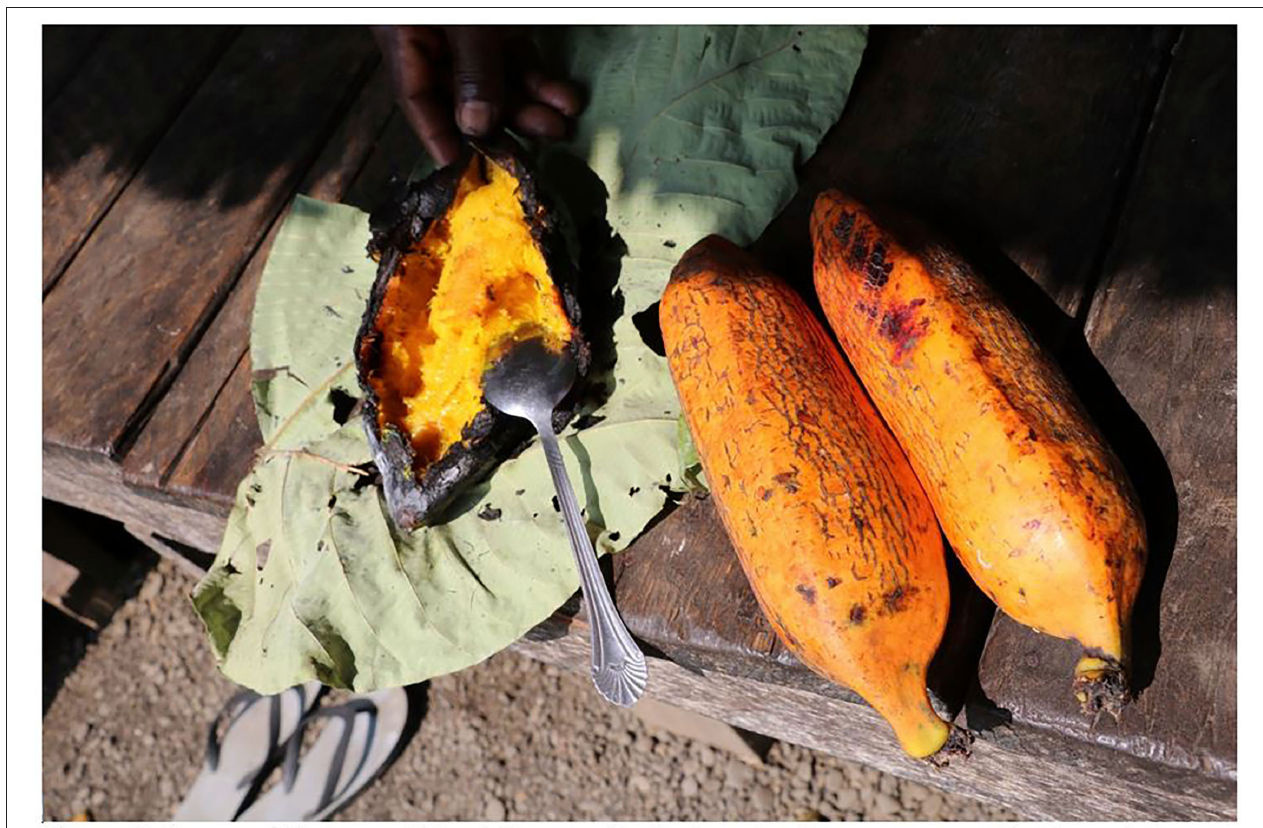
FIGURE 2 | Image of Solomon Islands banana. Left: A cooked banana opened to show rich colored flesh. Right: Fresh, unpeeled banana (Image courtesy Jessica E. Raneri, 2021).